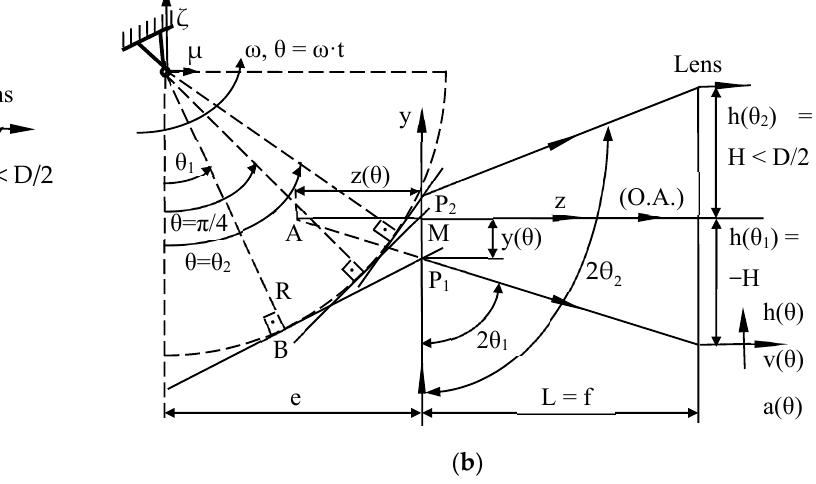
Figure 2. Polygon mirror (PM) scanning head: ( a ) 3D view with characteristic torques ( T ), parame- ters, incident, and reflected beams; ( b ) PM facet in three characteristic positions: for θ = θ 1 , π /4, and θ 2 , where θ 1 and θ 2 are the angles for which the margins of the objective lens are reached.